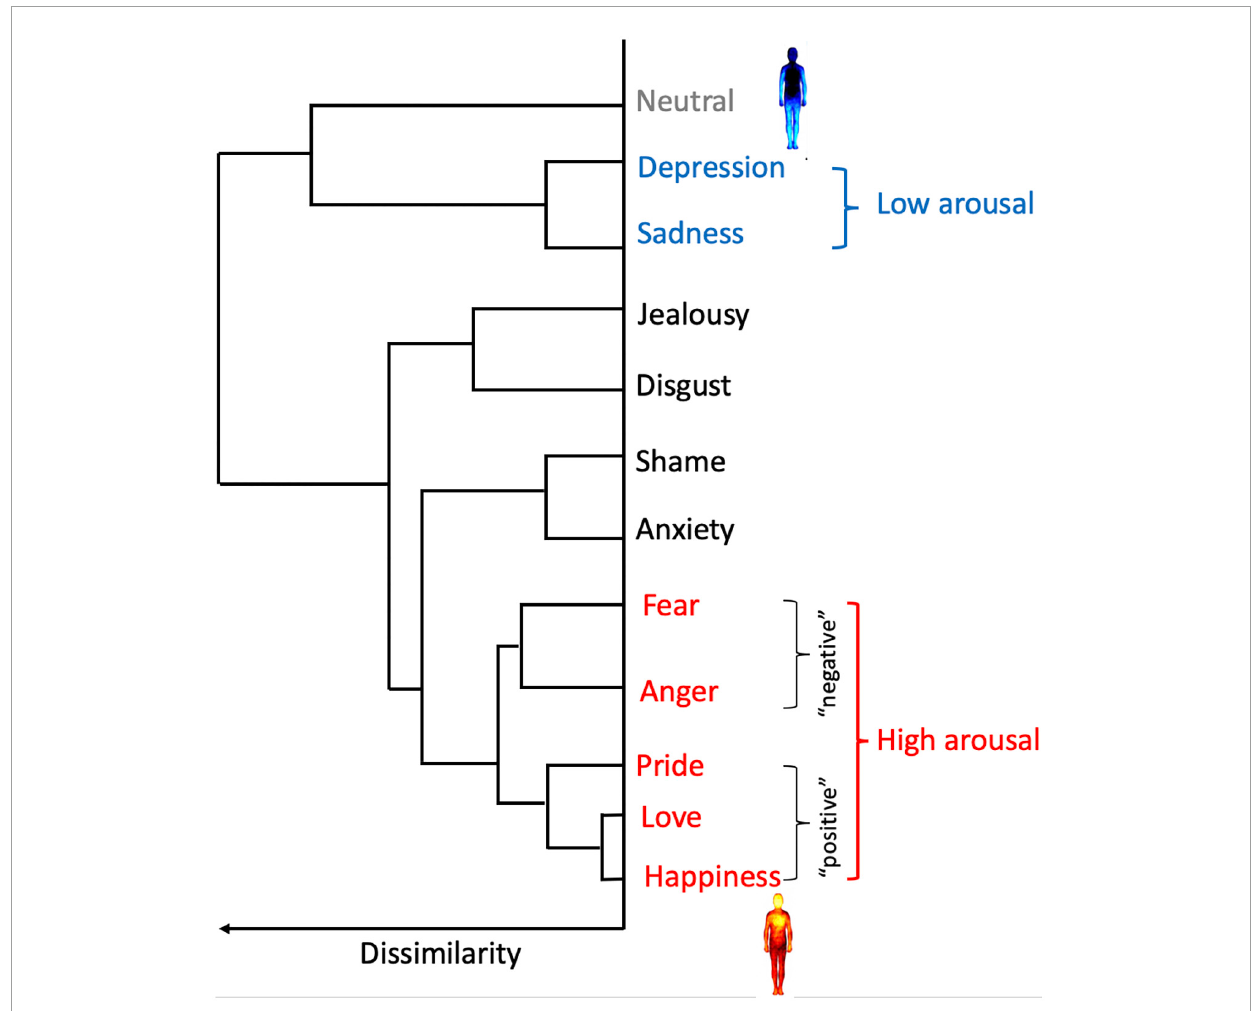
FIGURE2 Hierarchical structure of the similarity between the bodily sensation of emotions. Sadness and depression formed a cluster that was clearly separated from all the other emotions (i.e., low arousal). Furthest from this low arousal cluster was a cluster of “positive” high arousal emotions (happiness, love, and pride) and a cluster of “negative” high arousal emotions (anger and fear). Low arousal emotions are experienced as bodily deactivation (i.e., blue in the map of depression) while high arousal emotions are embodied as bodily activation (i.e., red in the map of happiness). The two central clusters included anxiety, shame, disgust, and jealousy/envy. The neutral state was distinct from all other categories. This cluster analysis was used to form the low arousal (sadness and depression) and the high arousal (happiness, love, pride, anger, and fear) groups used in our study. Adapted from Nummenmaa et al.